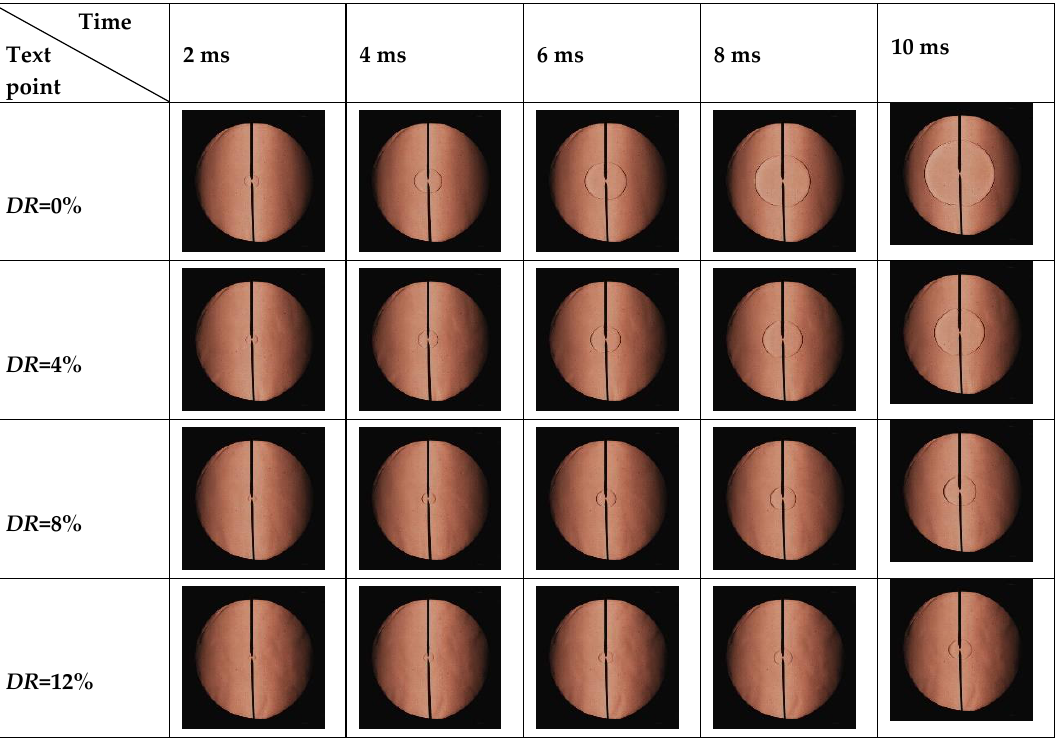
Figure A2. Schlieren photographs of flame propagation under di ff erent initial pressures ( DR = 2%, Figure A3. Schlieren photographs for flame propagation process under different dilution rates ( T u = Figure A3. Schlieren photographs for flame propagation process under different dilution rates ( T u = Φ = 1.0). 423 K, p u = 0.1 MPa, Φ = 1.0). 423 K, p u = 0.1 MPa, Φ = 1.0).